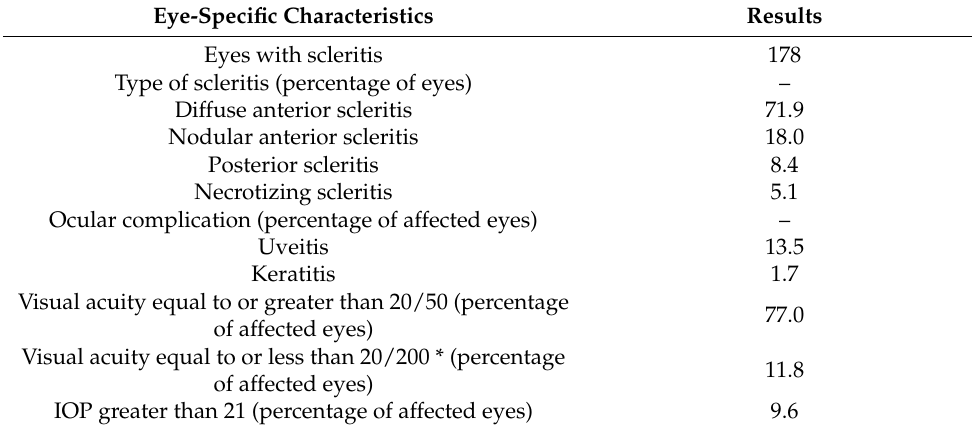
Table 2. Characteristics of eyes with scleritis.